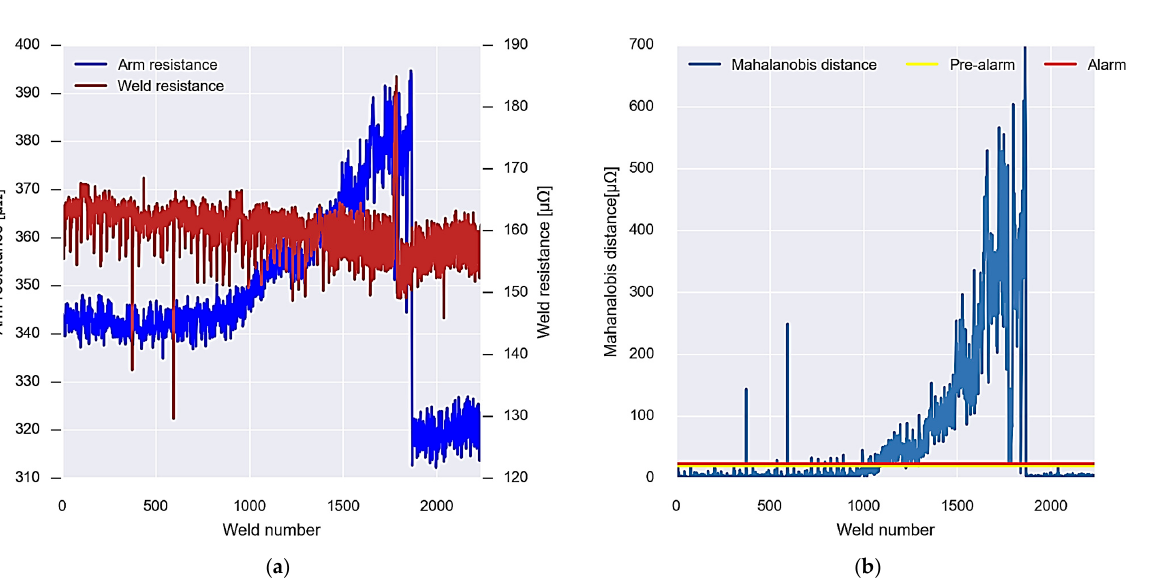
Figure 14. Gun 1 alarm system operation. ( a ) New incoming resistance data. ( b ) Analysis and recalibration of alarms.